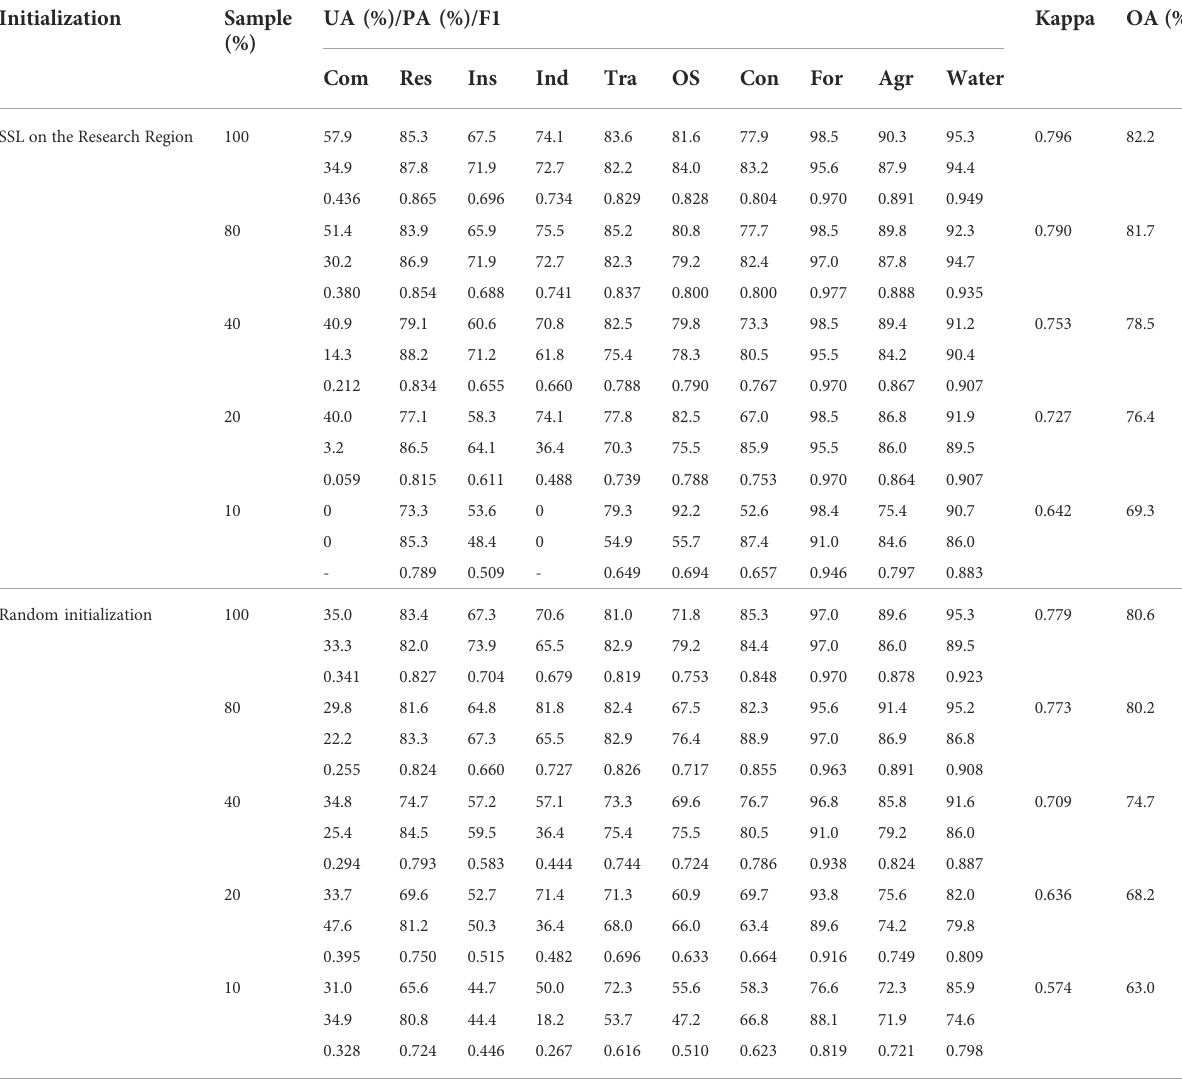
TABLE2EvaluationofthemodelsusingSSLinitializationandrandominitializationusingdifferentpercentageof fi netunesamples.Com:commercial, Res: residential, Ins: institutional, Ind: industrial, Tra: transportation, OS: open space, Con: construction, For: forest, Agr: agricultural.